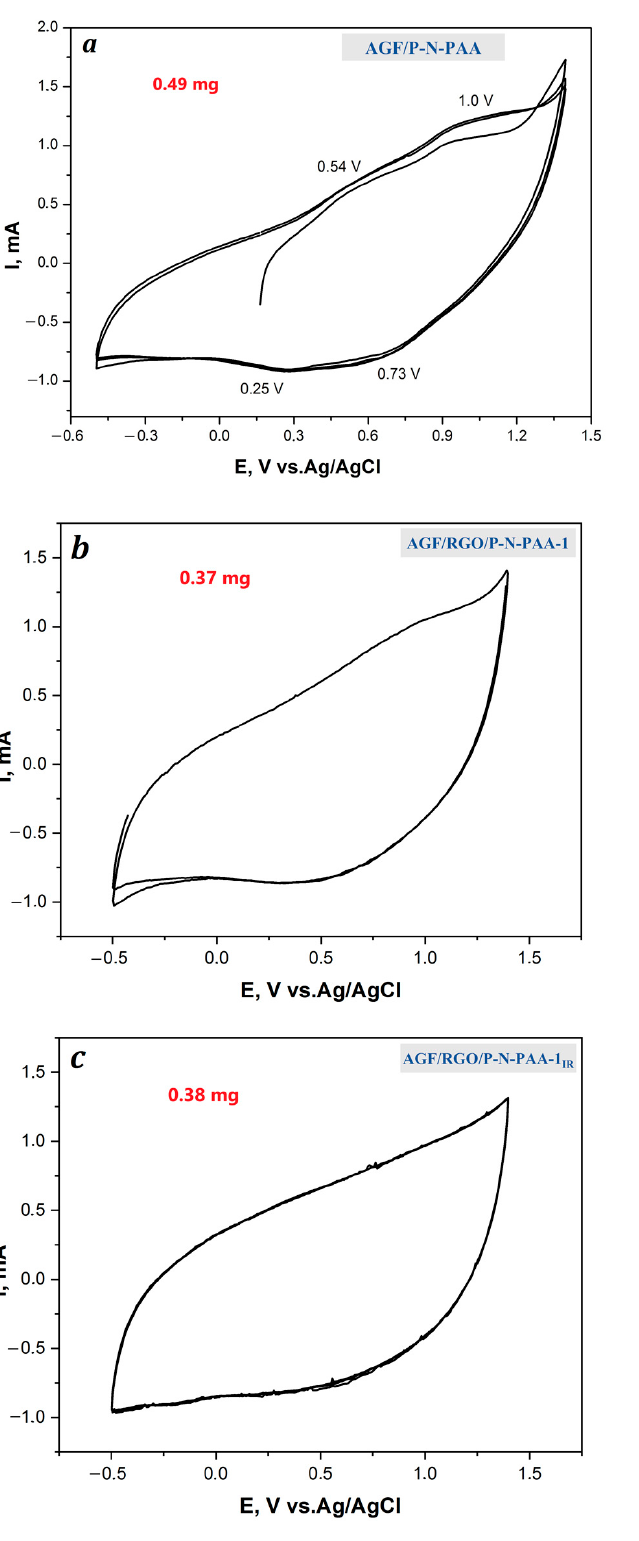
Figure 11. CV curves of the AGF/P-N-PAA ( a ) and AGF/RGO/P-N-PAA before ( b , d ) and after IR heating ( c , e , f ) at 5 mV·s –1 .